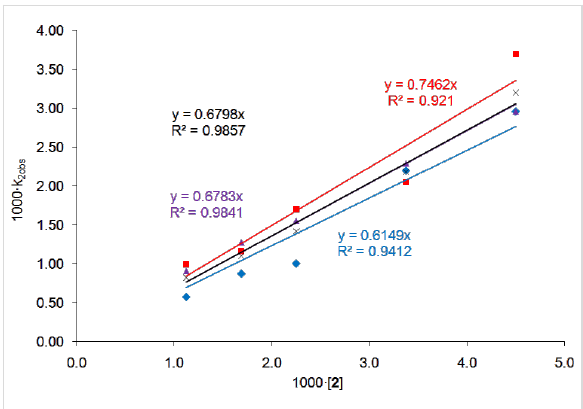
Figure 3: Plot of k 2obs against [2], showing that the reactions are first order with respect to the concentration of catalyst 2 (data presented in Supporting Information File 1). The red, blue and purple data and best- fit lines correspond to the three individual data sets given in Table 3. The black data and best-fit line correspond to the average